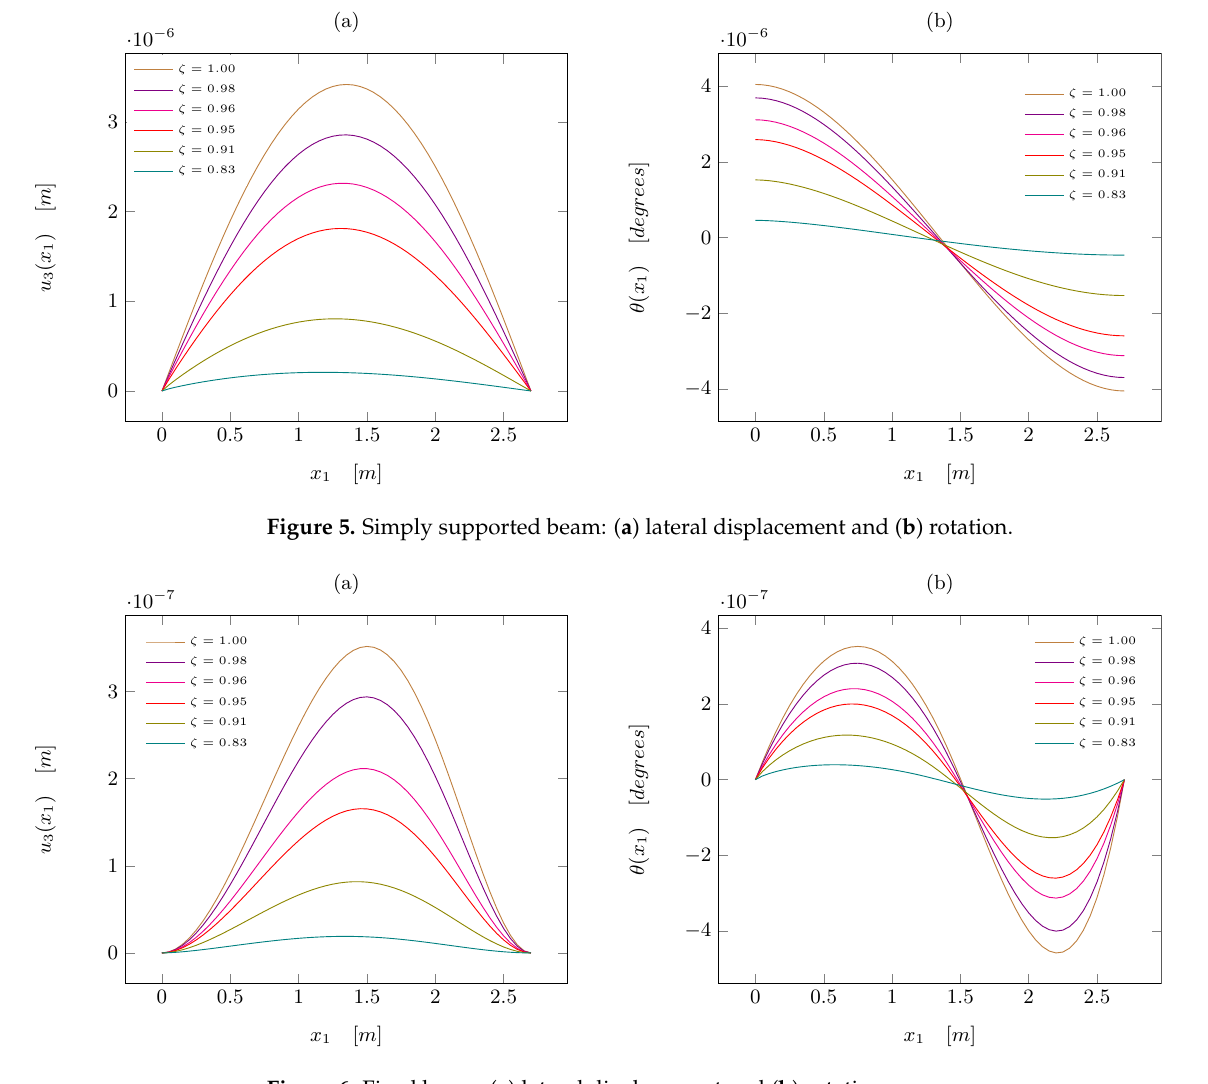
Figure 6. Fixed beam: ( a ) lateral displacement and ( b ) rotation.